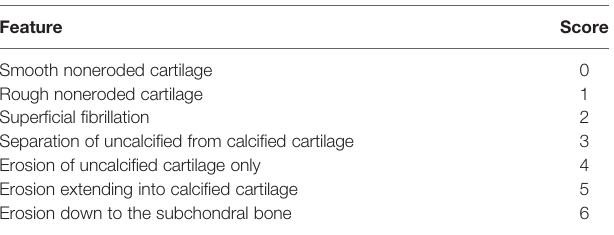
TABLE 1 | Cartilage erosion scoring system used to evaluate articular cartilage of